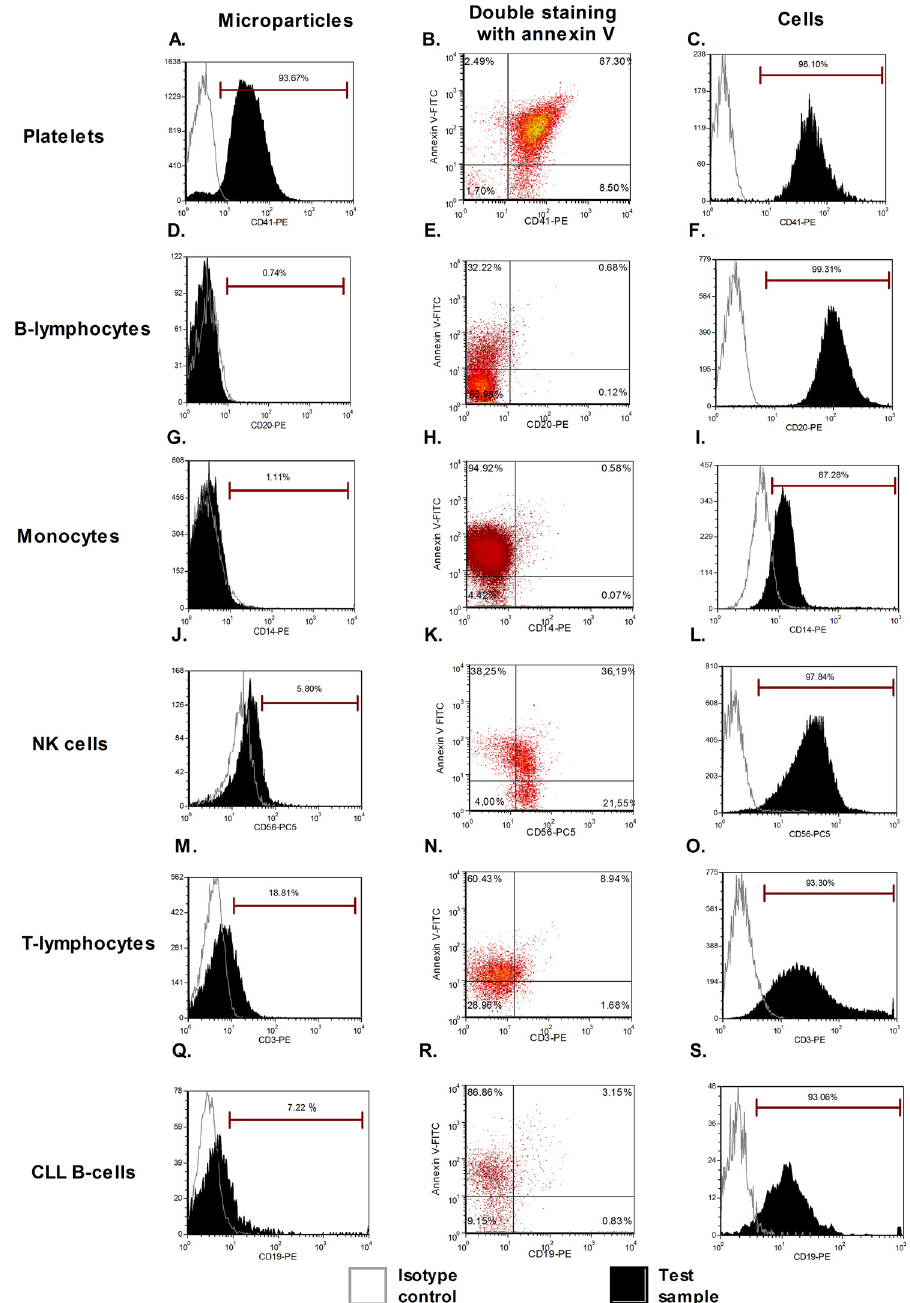
Fig 2. MP characterization by direct flow cytometry. A representative case for each staining is provided: for platelet-derived MPs, CD41 (A) associated with annexin-V labeling (B), similar to that found in the original cells (C). For MPs derived from other cellular sources, no antigen was detected (CD20 and CD14) (D/G) despite the expression of these markers on cells (F/I). An annexin-V positive population is present for all samples (ranging from 32% to 94%). For NK-cells, T-lymphocytes, and CLL B-cells, we observed a weak positive signal with CD56, CD3, and CD19, respectively. These signals were thus false positives, demonstrated by the use of other negative controls (Fig 3). Isotypes were used as negative controls (open line) and the tests are presented by filled